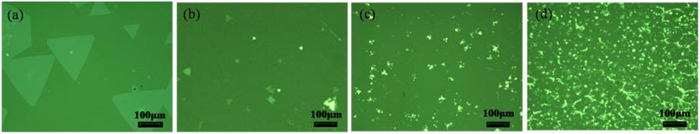
Optical microscope images of the synthesis MoS2 on Al2O3 with the carrier gas flow rate of 100sccm, 180sccm, 260sccm, 340sccm.